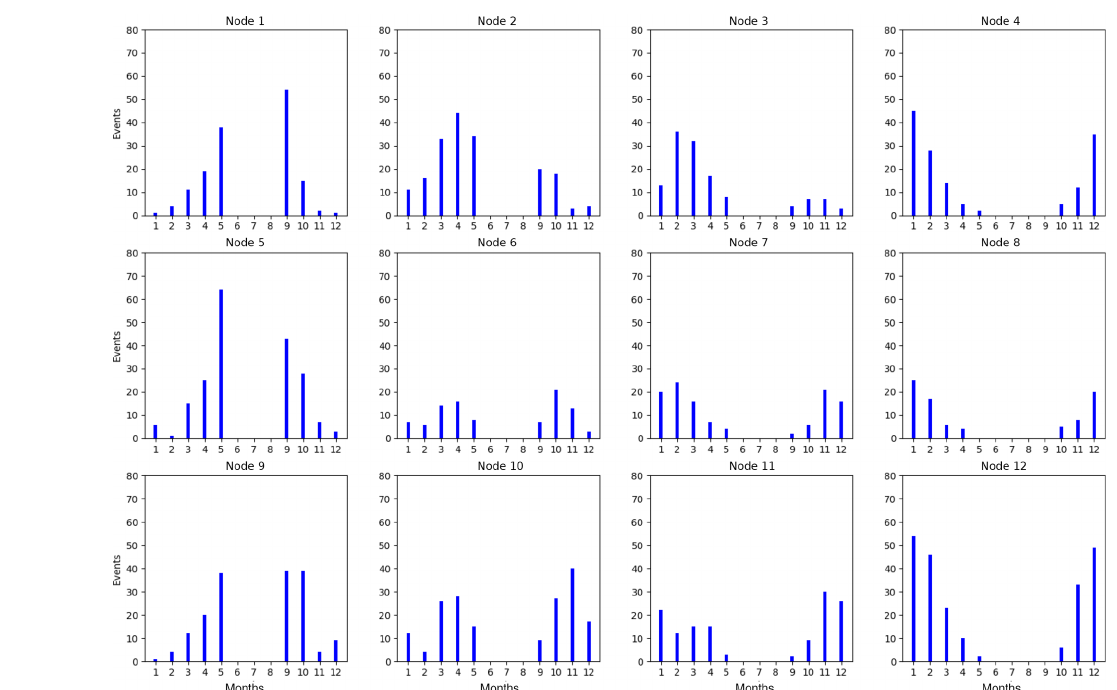
Figure 3. Number of occurrences for each node per